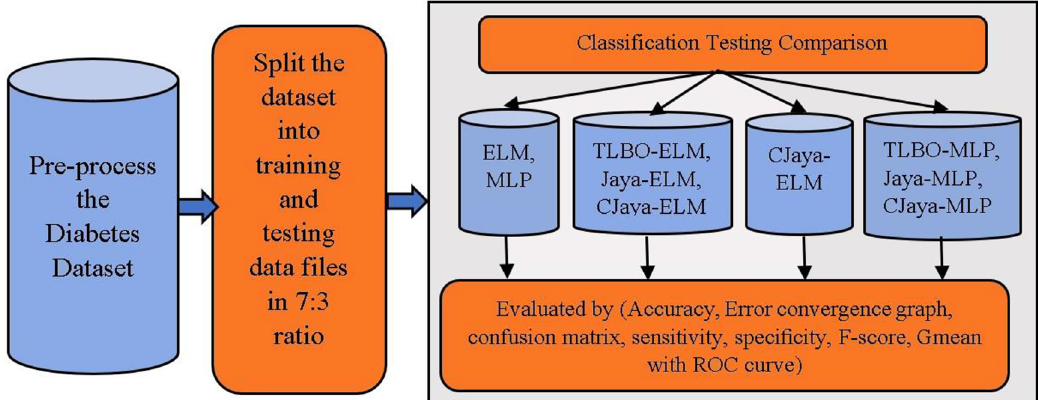
Figure 1: Overall system architecture of diabetes data